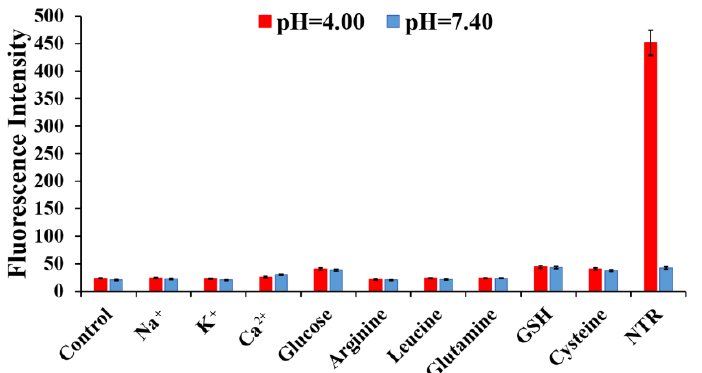
Figure 6. Fluorescence intensity of H6M (5 μ M) in the presence of NTR (10 μ g/mL) + NADH (500 μ M) or other biologically relevant analytes (10 mM) at pH 4.00 and 7.40: (1) control, (2) Na + , (3) K + , (4) Ca 2+ , (5) glucose, (6) arginine, (7) leucine, (8) glutamine, (9) GSH, and (10)